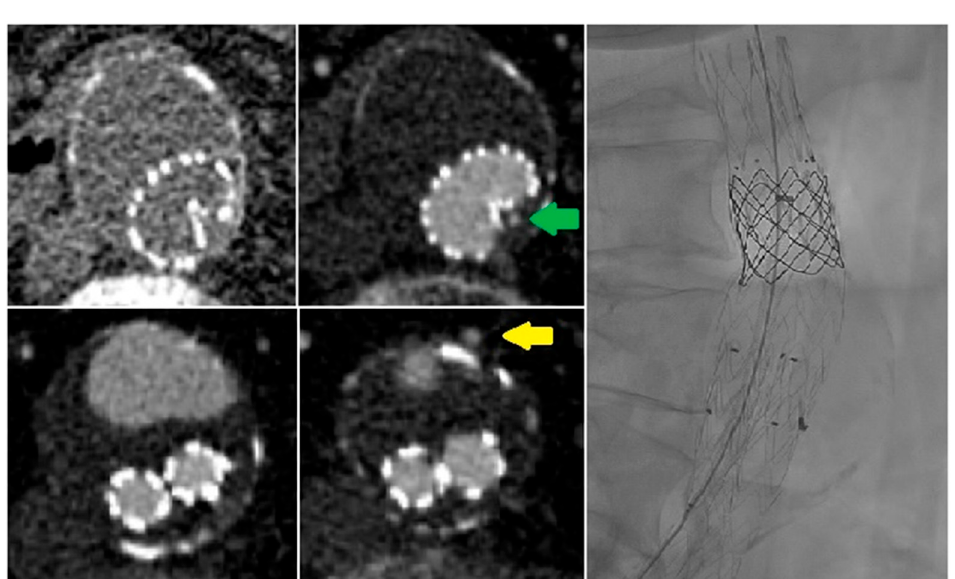
Figure 4. In patient 15, infolding of the posterior part of the proximal sealing stent of the endoprosthesis was observed in combination with a type Ia endoleak (green arrow). Because most of the endoleak was present in the anterior part of the aneurysmal sac in close relation to the inferior mesenteric artery (yellow arrow), there was uncertainty about the type of endoleak: type Ia, type II, or both. After dynamic computed tomography angiography, a type Ia endoleak was confirmed, and the patient was successfully treated with a large balloon-expandable stent re-expanding the proximal sealing stent of the endoprosthesis.